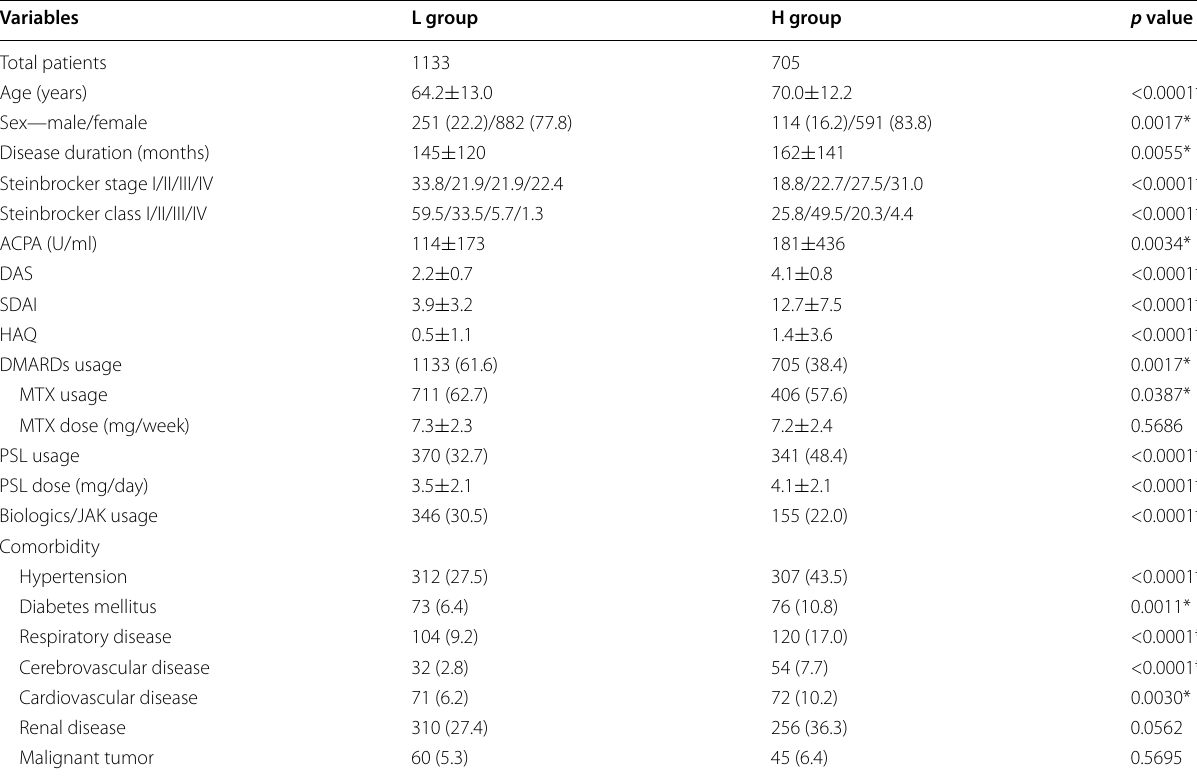
Table 2 Comparison between the remission or low disease activity group (L group) and moderate or high disease activity group (H group) by